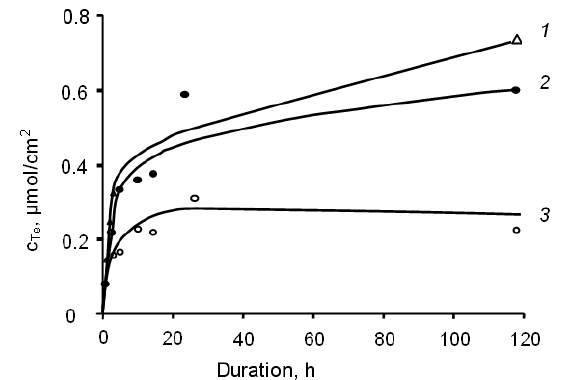
Figure 18. Kinetics of chalcogen sorption on PA surface at